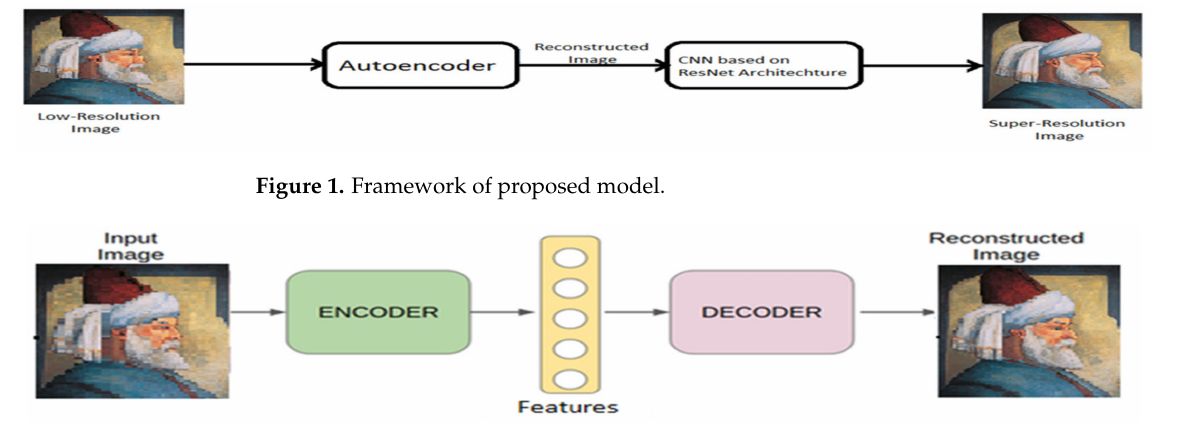
Figure 2. Autoencoder model.